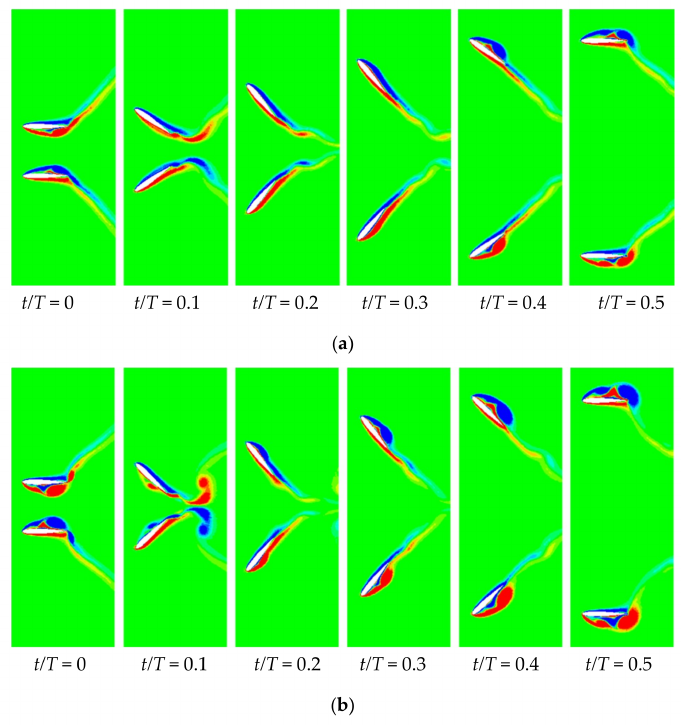
Figure 12. The vortex field during t/T = 0–0.5 under different K θ at k = 0.8: ( a ) K θ = 1; ( b ) K θ =